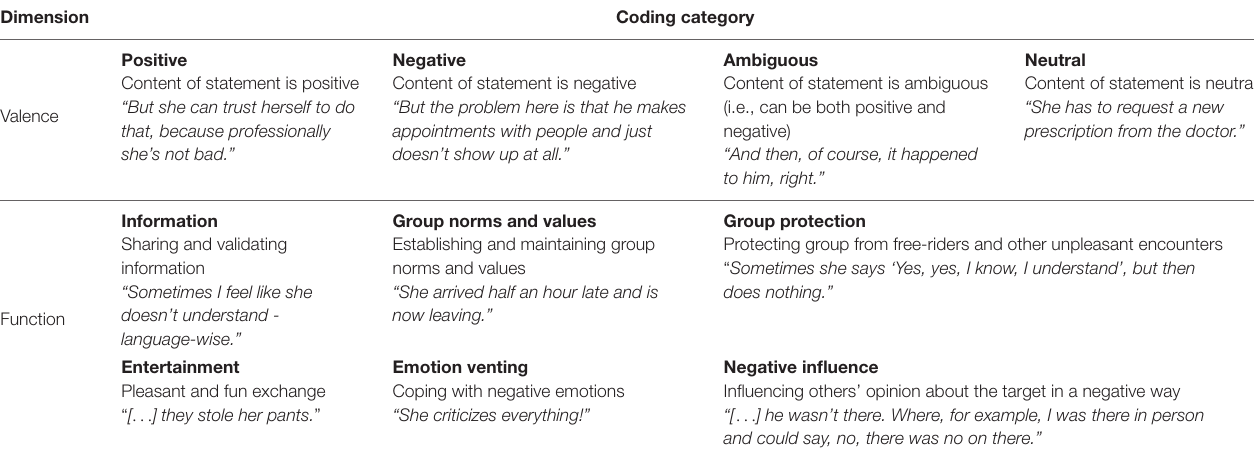
TABLE 1 | Annotation system for verbal gossip events. Dimension Coding category